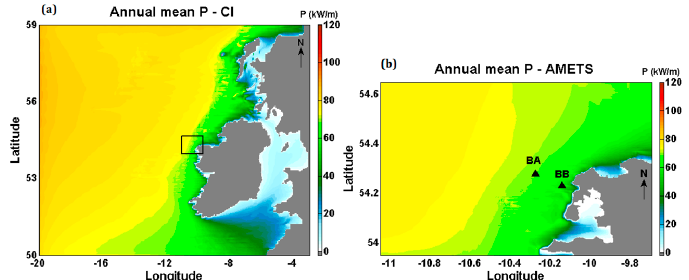
Figure 17. 12-year annual means of P (kW/m) for ( a ) CI model and ( b ) AMETS model.